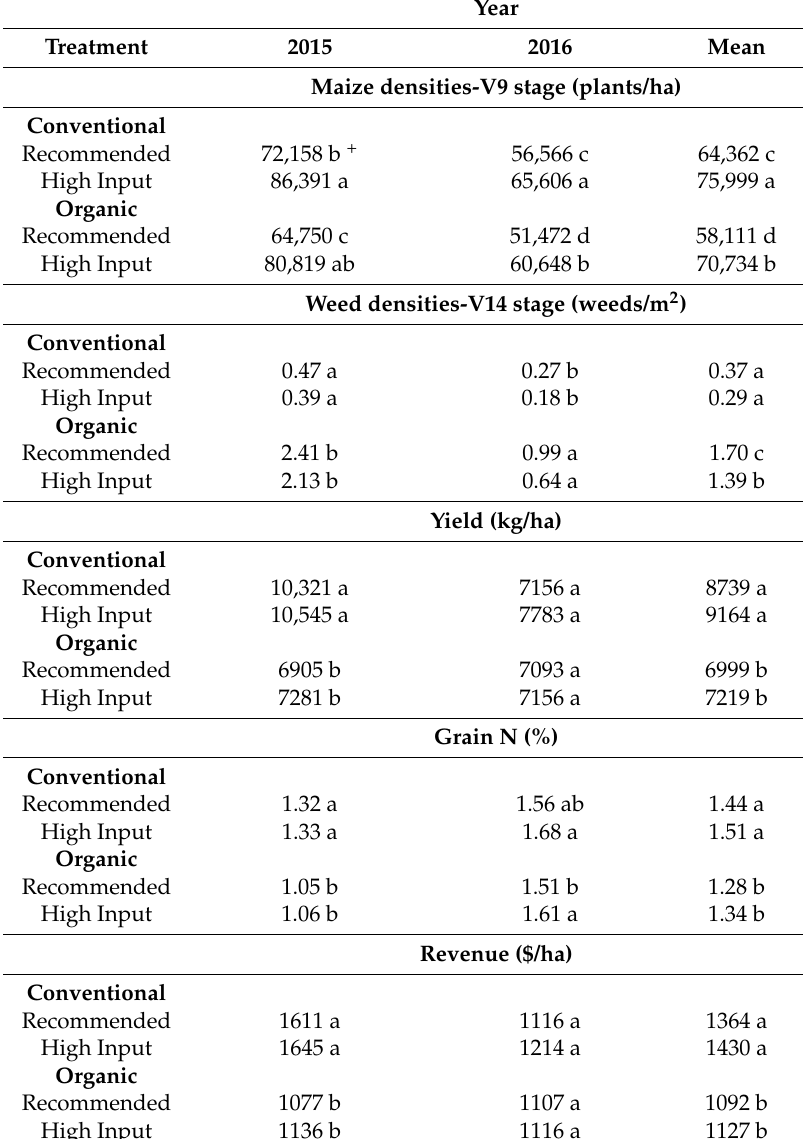
Table 3. Maize densities at the 9th leaf stage (V9), weed densities at the V14 stage, yield, grain N content and revenue of maize in 2015 in 2016 under conventional and organic cropping systems at recommended and high input management in central